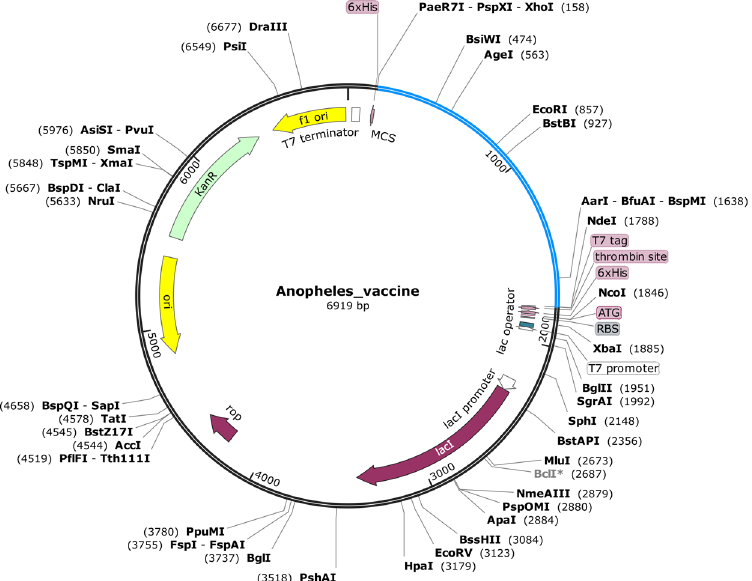
Figure 4. In silico cloning for adapted vaccine sequence into pET28a( + ) vector showing the region of choice in blue color surrounded between XhoI (158) and NdeI (1788) while the vector has shown in black lines.